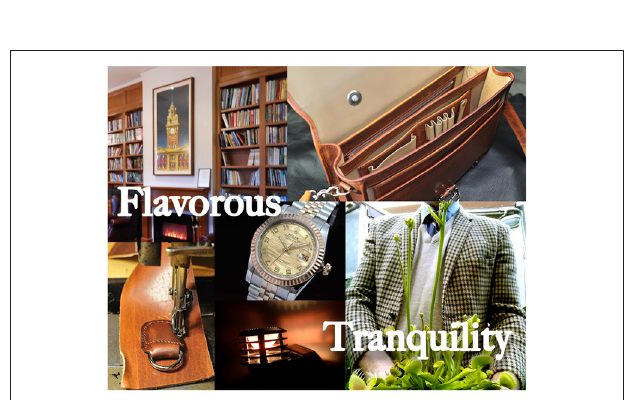
FIGURE 3 | An example of a moodboard, which is inspired by a DCP “flavorous